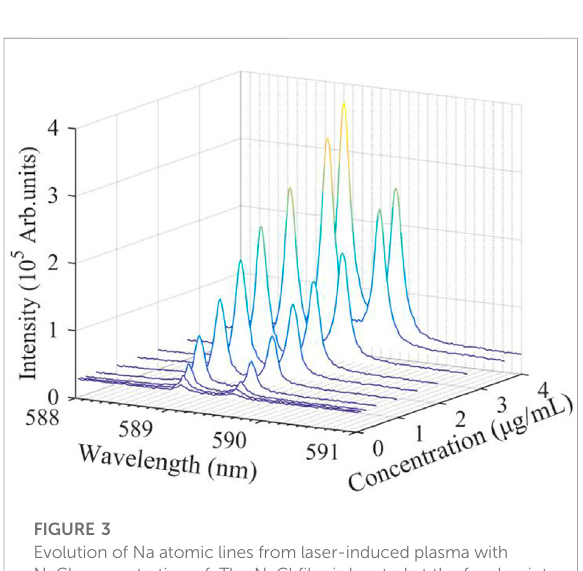
FIGURE 2 Typical emission spectrum of NaCl water solution plasma. The NaCl concentration is 4.00 μ g/ml. The NaCl fi lm is located at the focal point (DFLS = 100 mm).